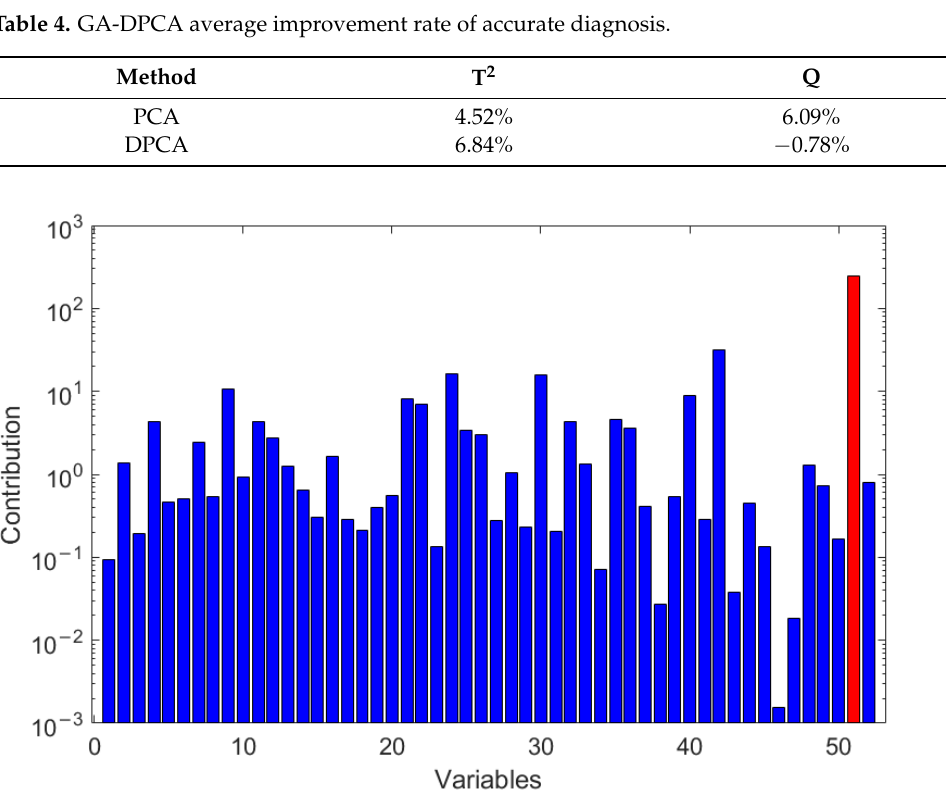
Figure 11. Contribution plots of fault 11.